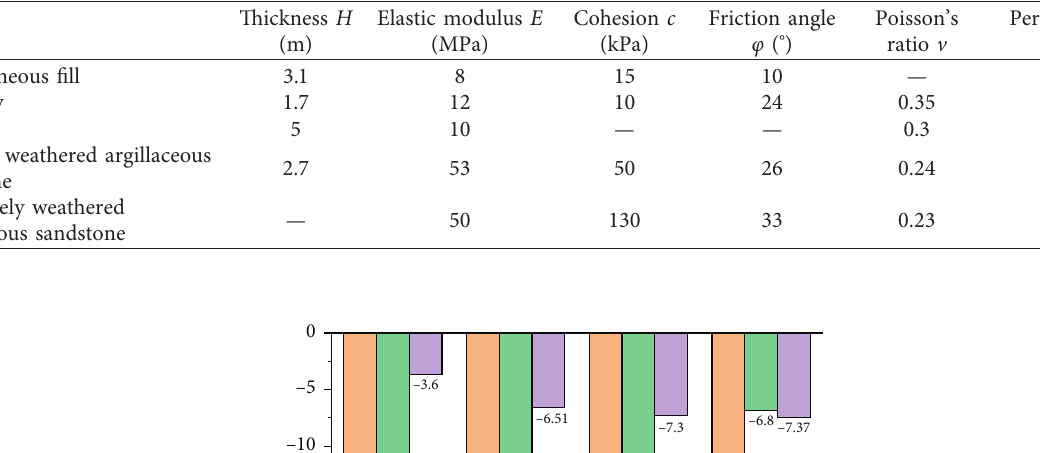
Table 2: The physical and mechanical parameters of the soil layer.